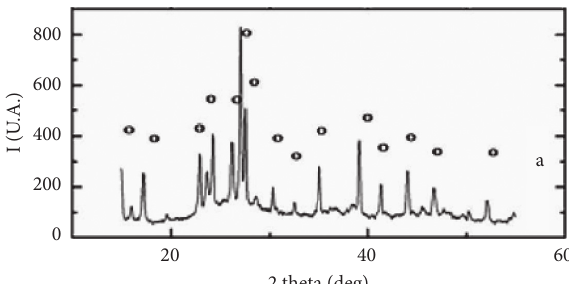
Figure 1: The XRD pattern of alumina powder obtained by sol-gel method from aluminum chloride (AlCl3), dried 100 o C/24